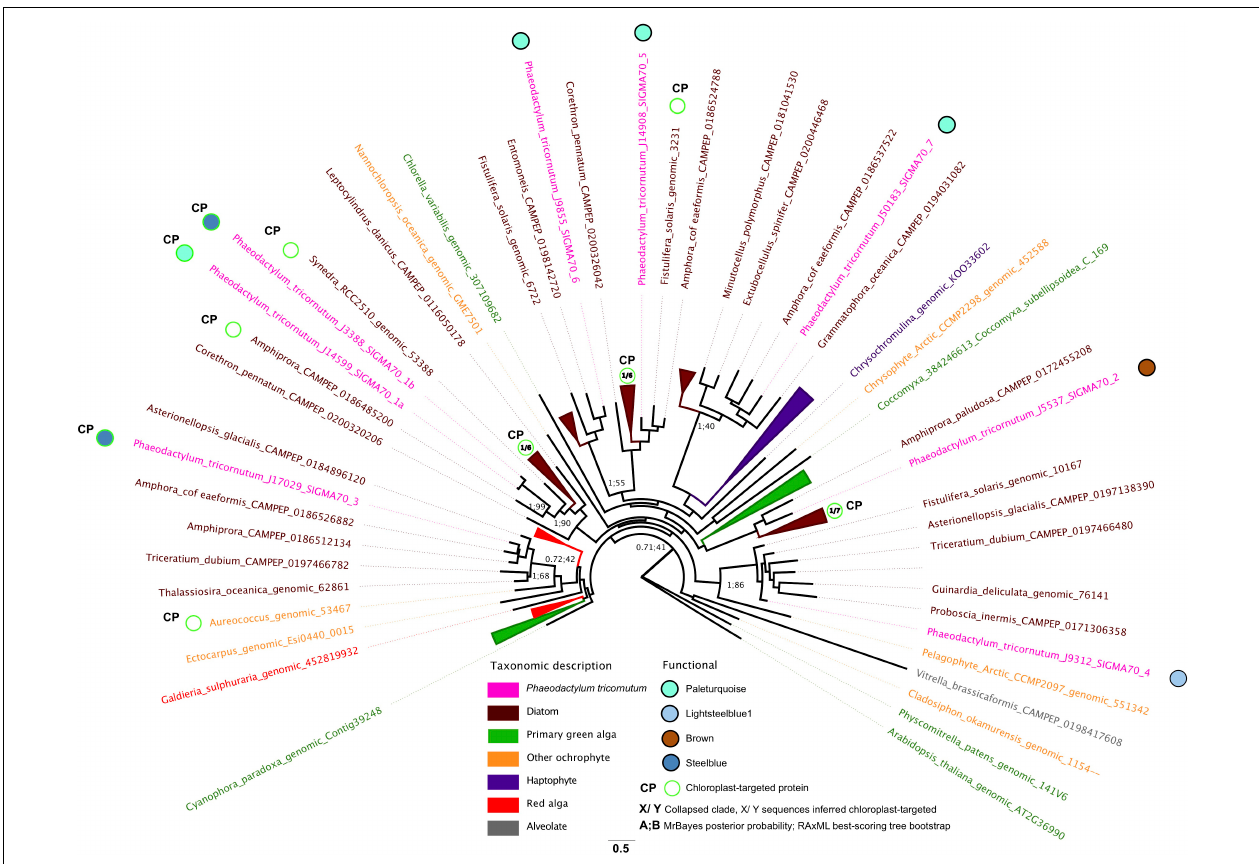
FIGURE 5 | Phylogenetic and transcriptional dynamics of P. tricornutum sigma factors. This Figure shows an unrooted best-scoring tree topology for an 86 taxa x 453 aa alignment of subsampled diatom and non-diatom sigma factors and realized using MrBayes v 3.2.7a with the Jones substitution matrix, 600,000 generations, two start chains and 0.5 burnin thresholds (Huelsenbeck and Ronquist, 2001); and RAxML v 8.2 with the PROTGAMMAJTT substitution model with 300 bootstrap replicates (Stamatakis, 2014). Chloroplast-targeting predictions were performed using ASAFind with SignalP v 3.0 (Gruber et al., 2015); and HECTAR (Gschloessl et al., 2008) under default conditions. Branches are colored by phylogenetic affiliation and bootstrap values of nodes recovered with > 40% support are shown. Eight P. tricornutum sigma factors are labeled with PhaeoNet merged module repartition and chloroplast targeting sequences were predicted by HECTAR or ASAFind (Gruber et al.,